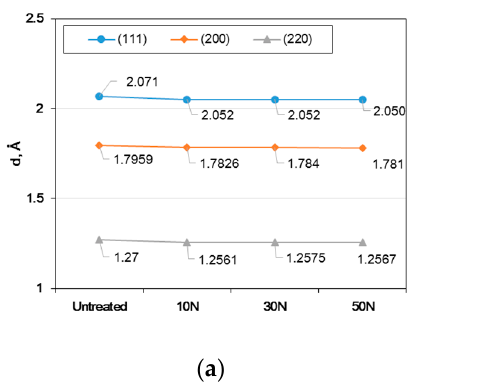
Figure 13. The e ff ect of the static load under the critical UNSM condition on the corrosion factors of Alloy 600.